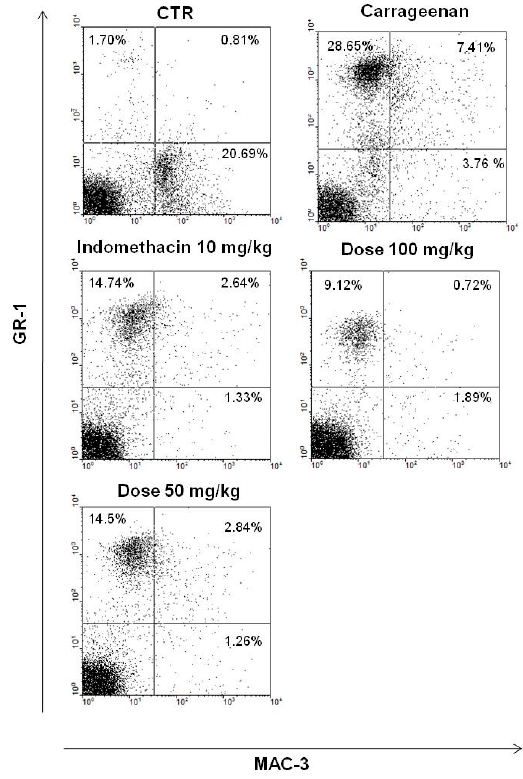
Figure 7. Reduction of differential neutrophil count, induced by carrageenan, in the presence of EtOAc of A. occidentale . Data was analyzed using the WinMDI 2.9 software (Joseph Trotter, Scripps Research Institute, San Diego, CA, USA).